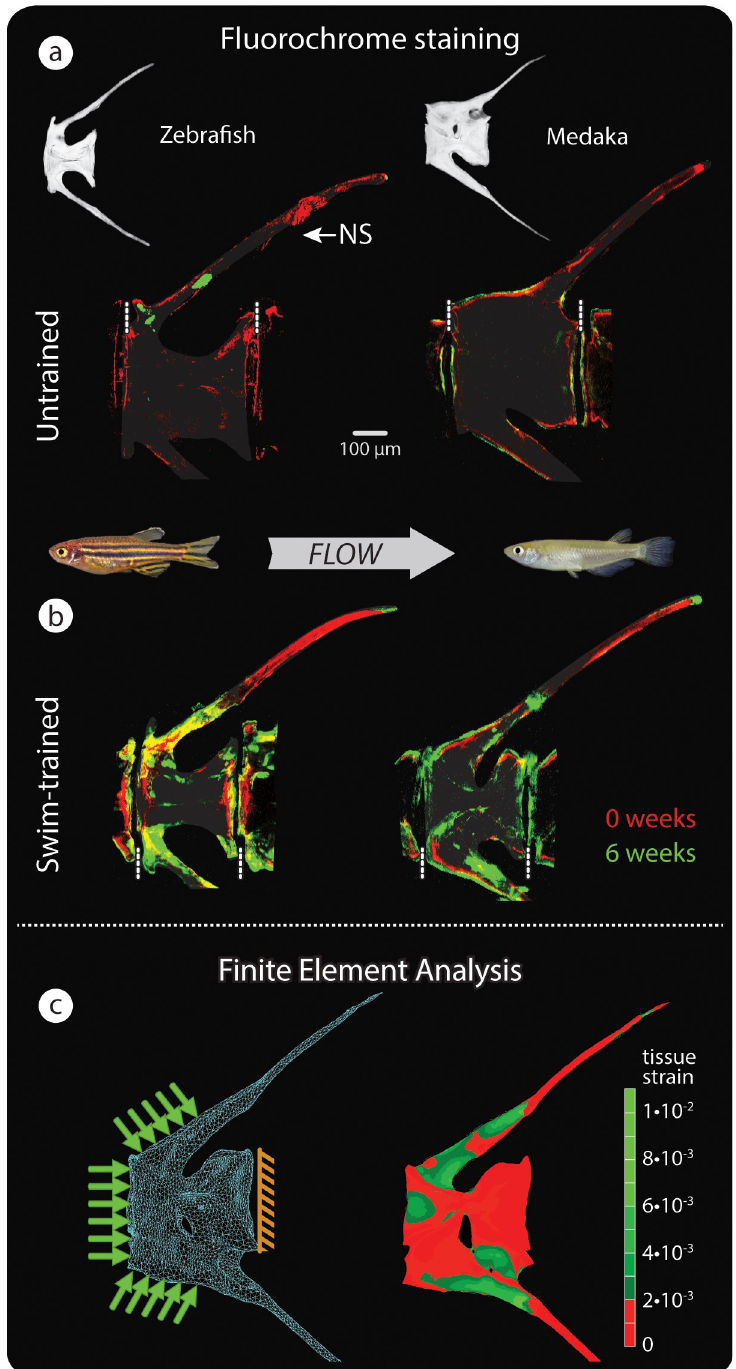
Fig 2. Vertebral bone formation in response to load. (a–b) Bone formation detected by sequential intraperitoneal fluorochrome injections in untrained (a) and swim-trained (b) zebrafish (left, osteocytic) and medaka (right, anosteocytic), each of the 4 groups comprising n = 4 fish. Alizarin red was injected at t = 0 weeks, and calcein green was injected at t = 6 weeks of swim training. Dashed, vertical white lines mark the border between vertebrae. (c) FE model (left) and FEA results (right), showing von Mises strains in a loaded medaka vertebra. Note similarity of peak strains predicted by FEA in (c) and regions of intense bone formation in response to load, indicated by fluorochrome double labeling (b). The distal HSs are cropped in fluorochrome and FE renderings. FE, finite element; FEA, finite element analysis; HS, hemal spine; NS, neural spine.